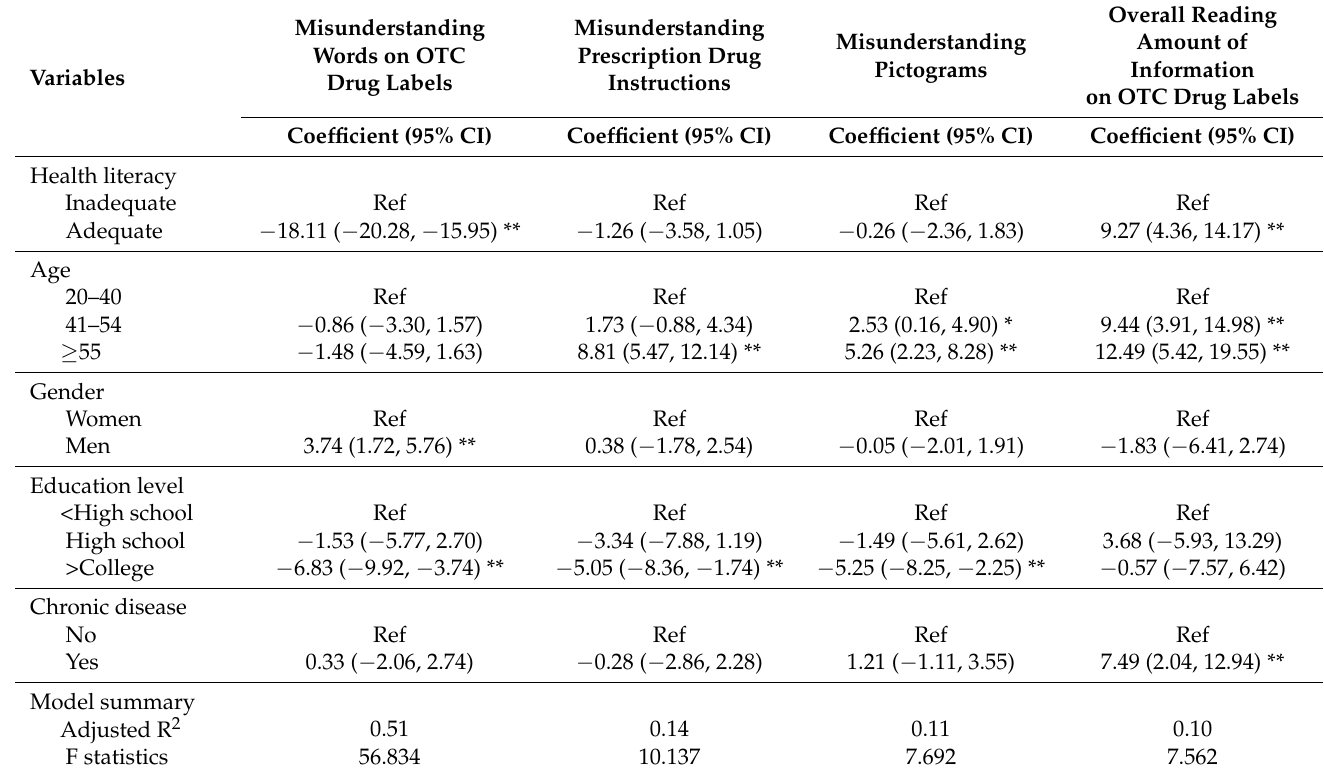
Table 5. Factors influencing the misunderstanding and the reading amount of medication